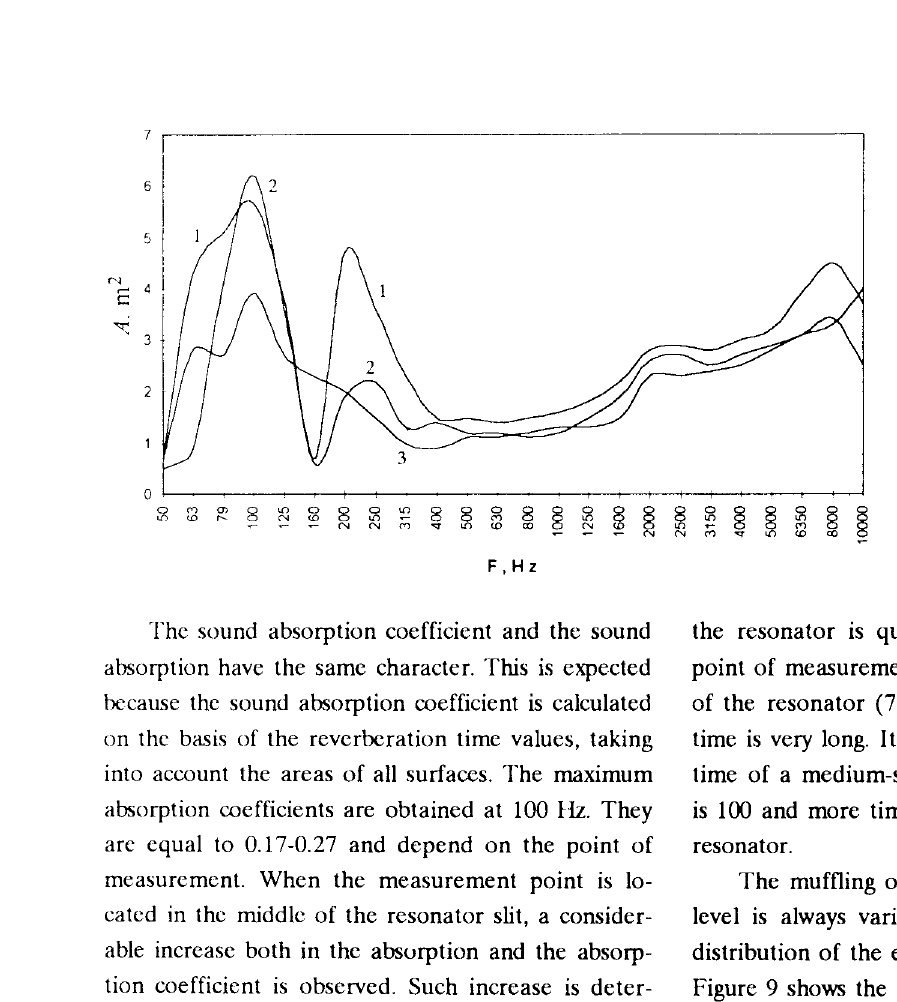
Fig. 6. The frequency-dependenee of the sound absorption of the iso lated resonator with a cross-shaped slit at 0 - 30 dB.